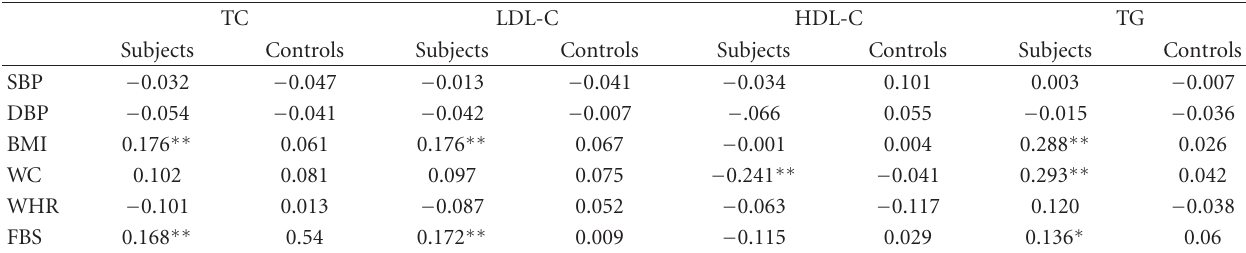
Table 3: Showing Spearman’s correlations between lipid profile and clinical parameters.